Question: Describe this figure in one sentence.
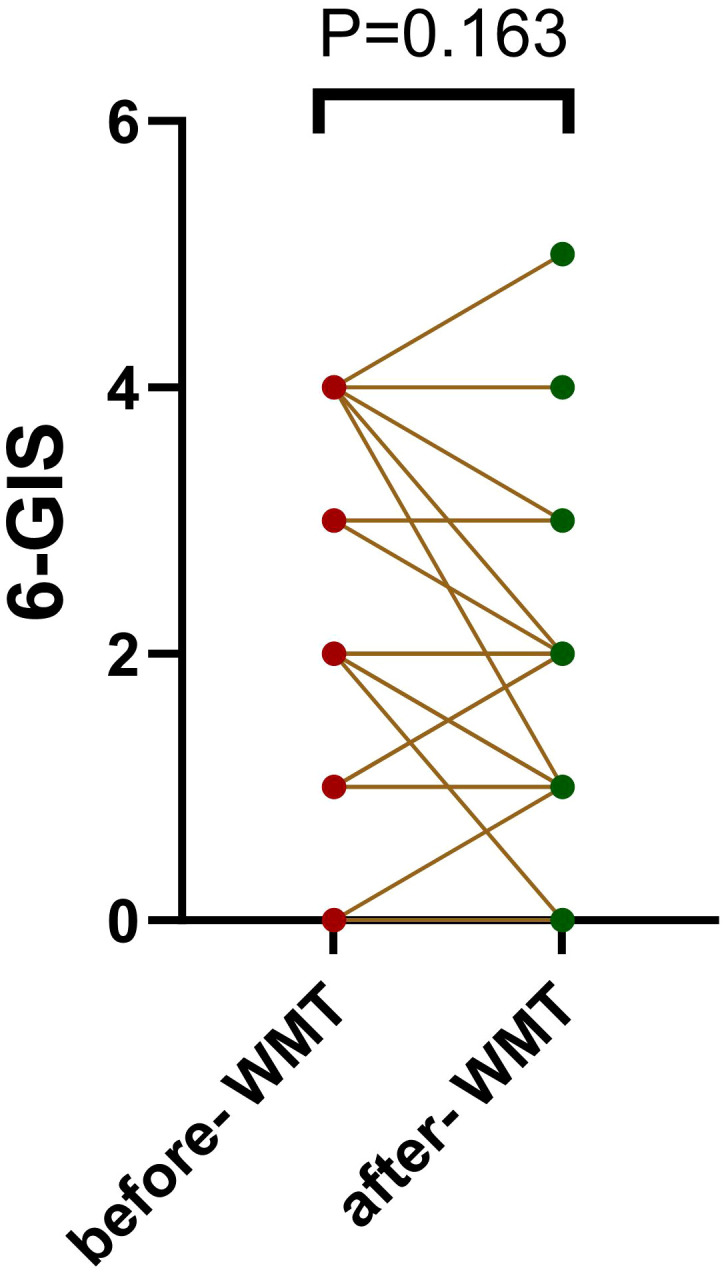
Answer: Comparison of changes in 6-GIS scale scores in children with ASD before and after single-donor WMT.